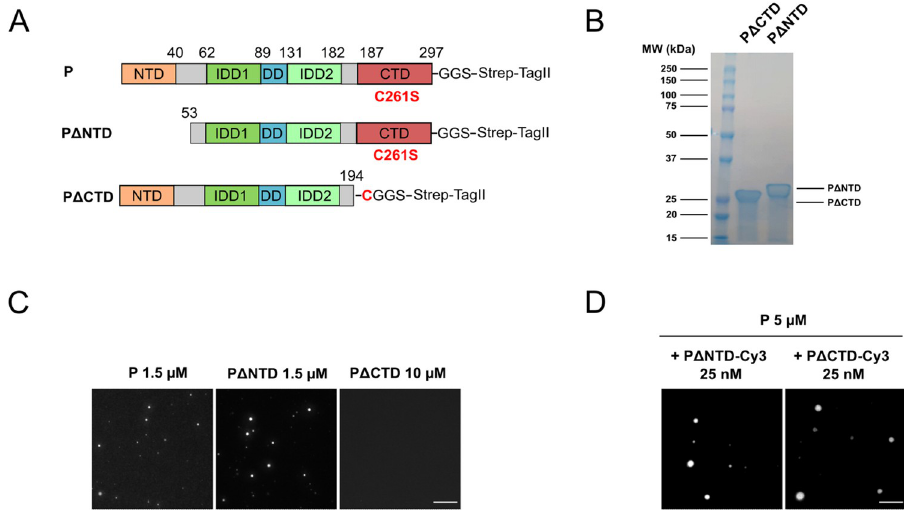
Fig 5. Phase separation of RABV P deletion mutants. A) Schematic representation of the domain organization of RABV P deletion mutants used. The P Δ NTD construct is deleted from amino acids 1–52. The P Δ CTD construct is deleted from amino acids 195–296. B) SDS PAGE analysis of purified P Δ CTD and P Δ NTD. C) P deletion mutants droplets were observed by fluorescence microscopy at different concentrations in presence of 5% PEG 8000 in 125 mM NaCl, 20 mM Tris-HCl pH 7.5 buffer. The mix contained 25 nM of fluorescent P deletion mutant. Scale bar: 10 μ m. D) Non-fluorescent P at 5 μ M was incubated with either fluorescent P Δ NTD or fluorescent P Δ CTD constructs at 25 nM in presence of 5% PEG 8000 in 50 mM NaCl, 20 mM Tris-HCl pH 7.5 buffer. Presence of droplets was assessed by fluorescence microscopy. Scale bar: 10 μ m.